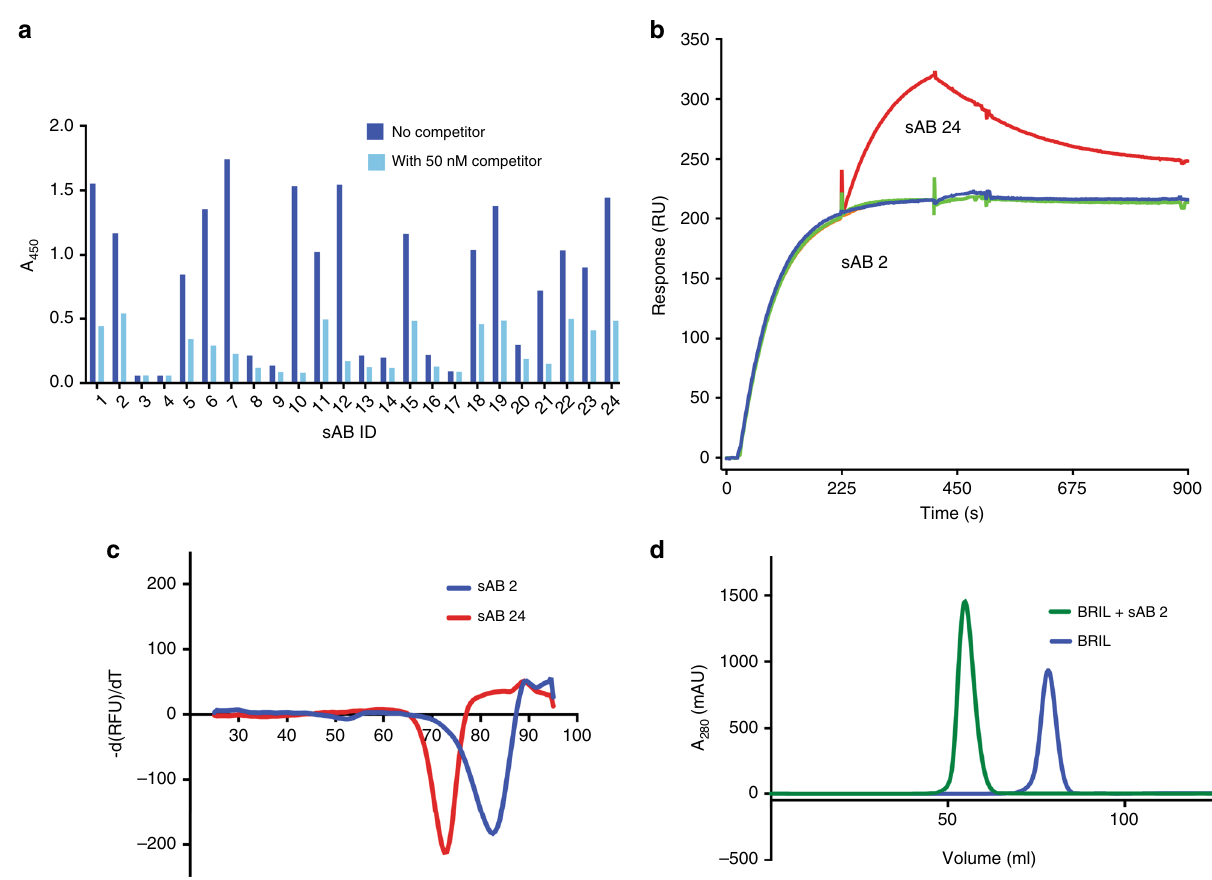
Fig. 1 Characterization of the sABs against BRIL. a Representative single-point competitive phage ELISA of the binders obtained from phage display. Clones with strong ELISA signal in absence of competitor (dark blue bar) and good competition ratio are chosen for subsequent characterization. Low ELISA signal in presence of the competitor in solution (light blue bar) is a measure of good competition ratio. b Representative epitope binning by SPR shows that sAB2 (blue curve) and sAB24 (red curve) bind to two different epitopes. Most of the sABs share identical or partial footprints with sAB2. One such sAB sharing the same footprint with sAB2 is shown in green curve. c Thermal melting curves of sAB2 and sAB24 as monitored by DSF. d aSEC pro fi les show that the sABs form monodispersed complexes with